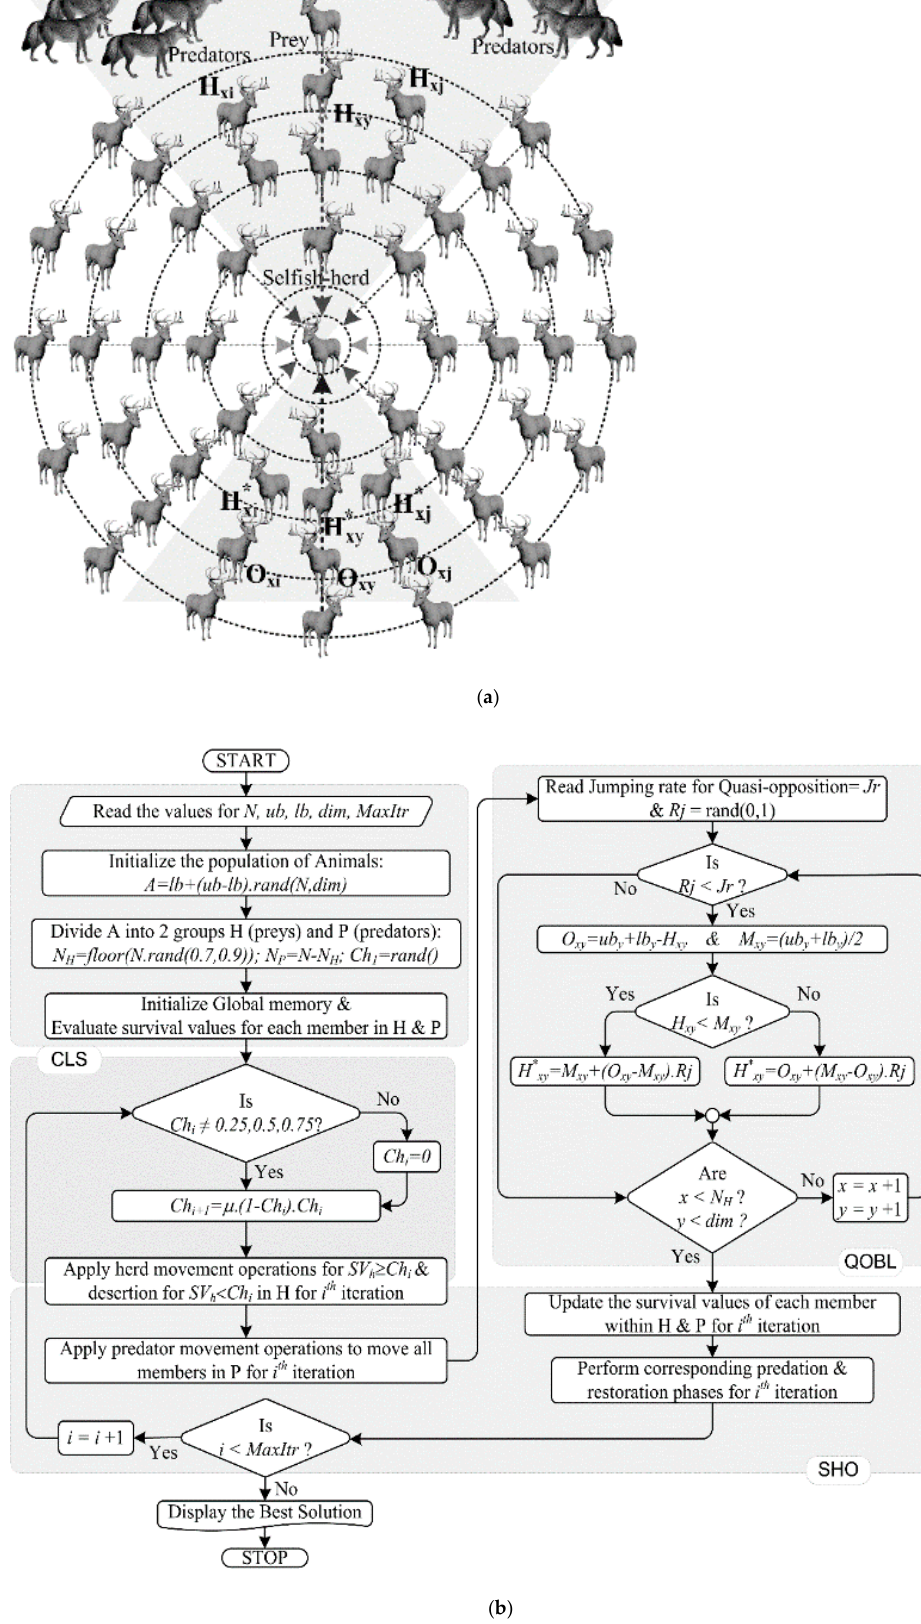
Figure 7. QCSHO algorithm: ( a ) chaotic herds’ encircling and ( b ) flowchart.